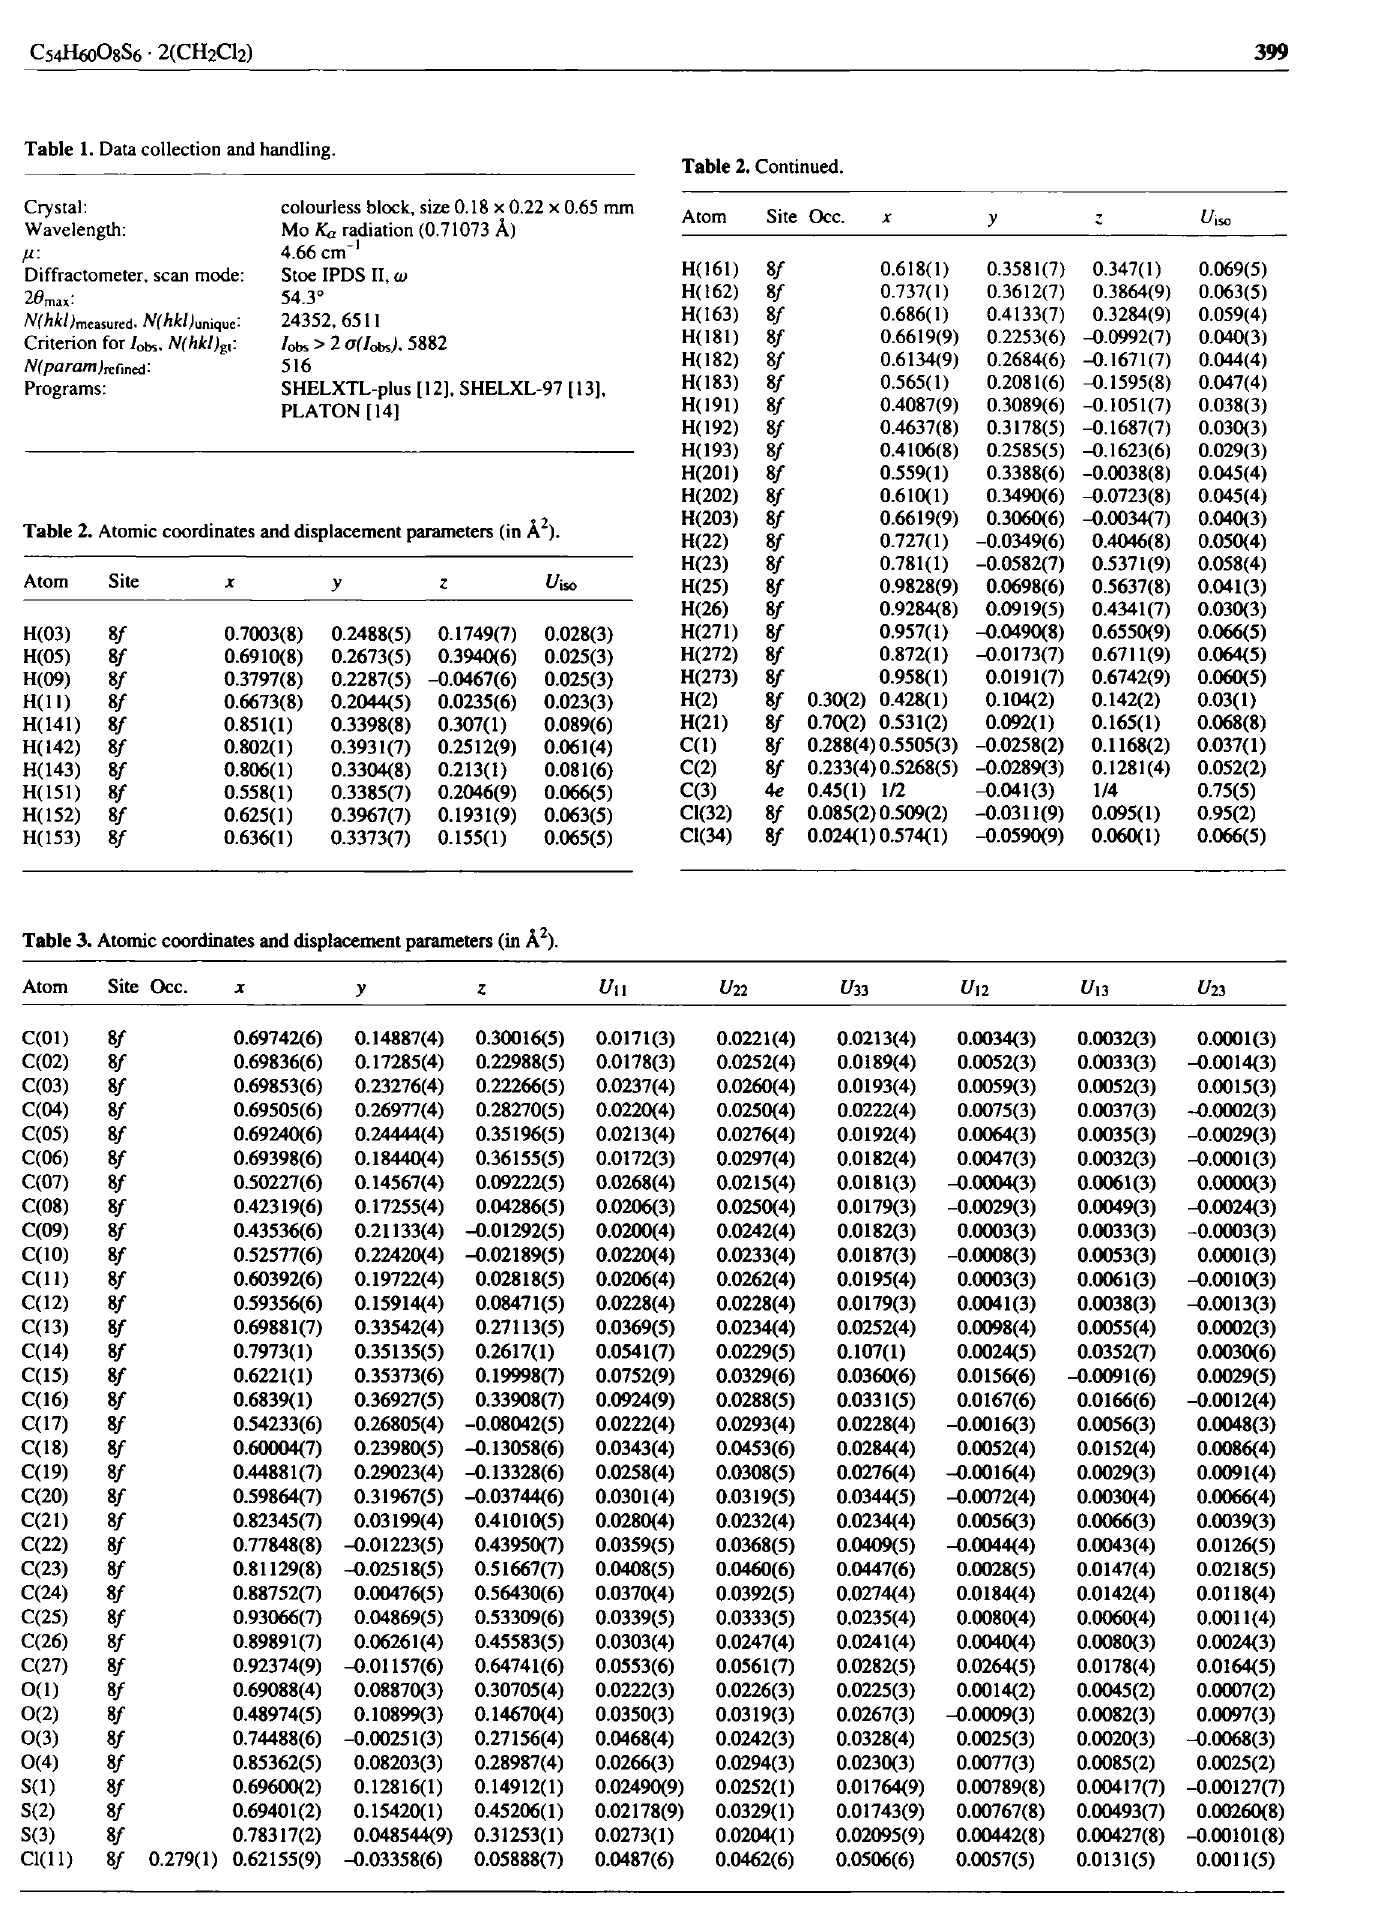
Table 1. Data collection and handling.